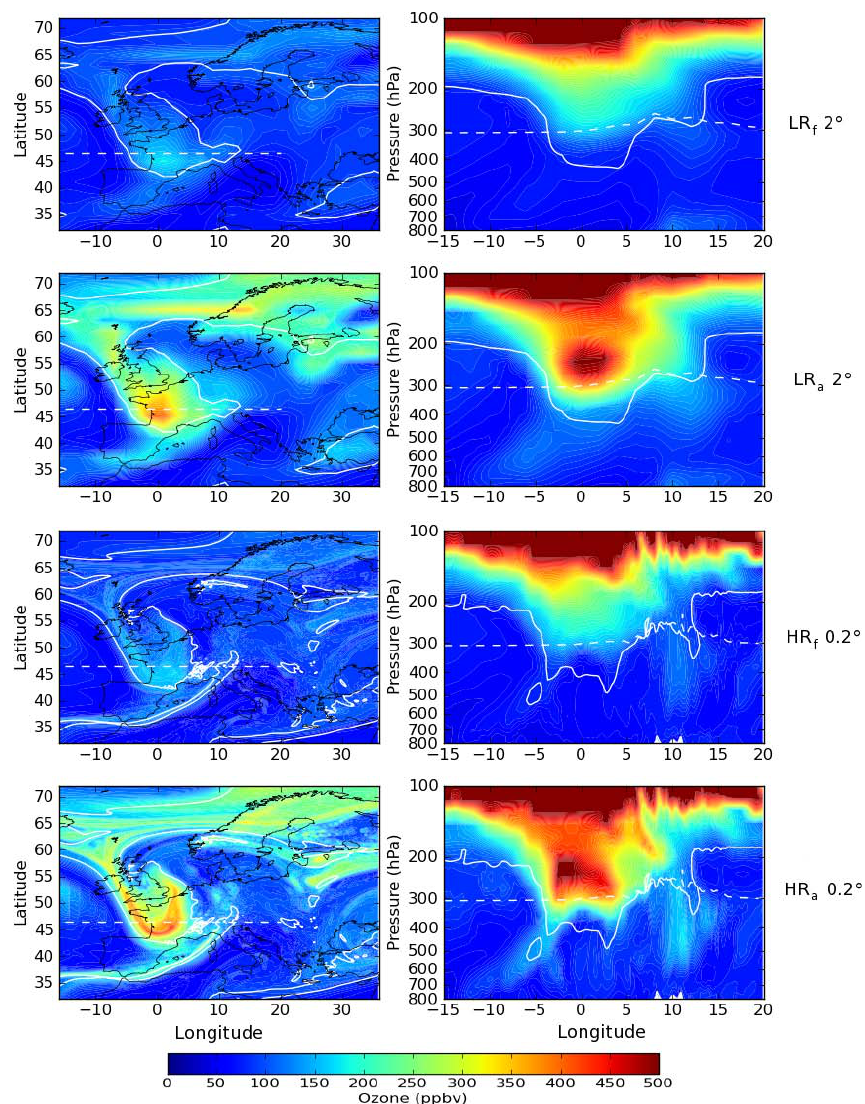
Fig. 8. Ozone fields for 17 July 2009, 15:00UT, in ppbv (parts per billion by volume) for various experiments: LR f : Low Resolution (2 ◦ ) free run; LR a : Low Resolution (2 ◦ ) analyses; HR f : High Resolution (0.2 ◦ ) free run and HR a : High Resolution (0.2 ◦ ) analyses. Left hand side panels show longitude-latitude fields for a given model level; right hand side panels show longitude-pressure cross-sections. White dashed line associate vertical and horizontal distribution by showing the same location between left hand side and right hand side panels. The white solid lines identify the 2PVU